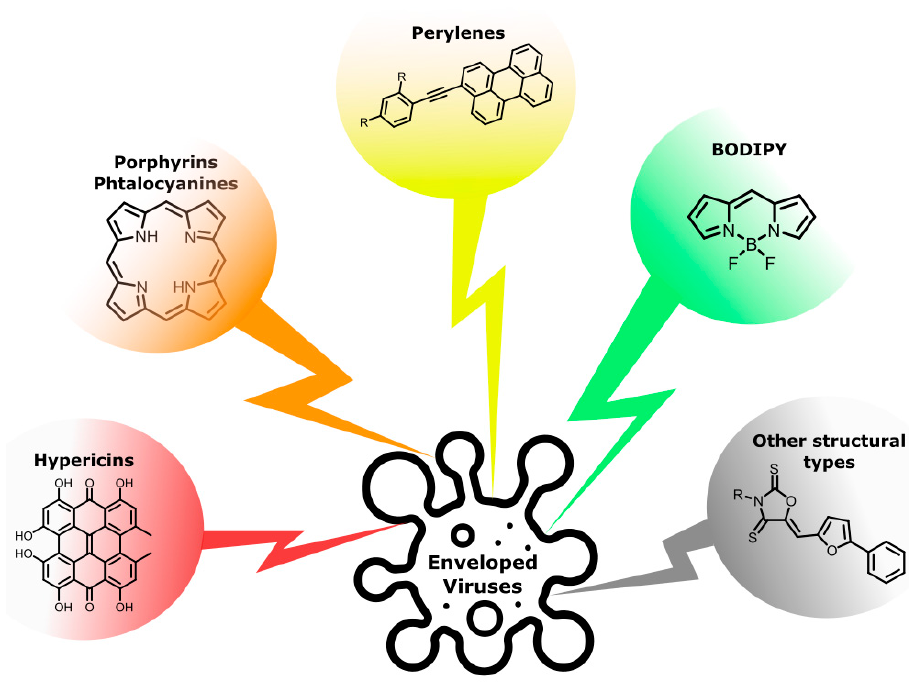
Figure 1. Structural types of promising antiviral photosensitizers with a possible affinity to lipids.